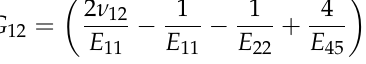
Table 3. Elastic stiffness index in CD computed from the displacement measurement by the optical extensometry and from machine crosshead, as well as the edgewise compression strength in CD.